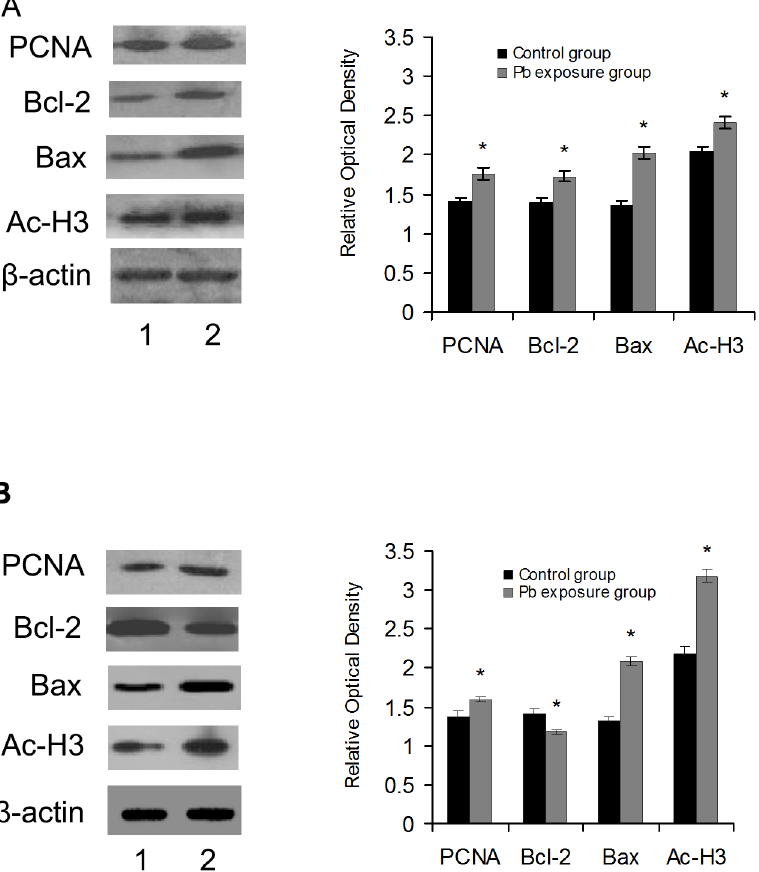
Fig 4. Effects of Pb on cardiac tissue protein expression. Effects of Pb exposure on the protein expression of PCNA, Bcl-2, Bax and acetyl-H 3 in cardiac tissue at 12 day after Pb exposure (A) and 40 day after Pb exposure (B). The corresponding bar graphs represent densitometric quantification. n = 6 experiments. Probability values are indicated above bars: * p < 0.05 versus control. 1 stand for control group, 2 stand for Pb exposure group.